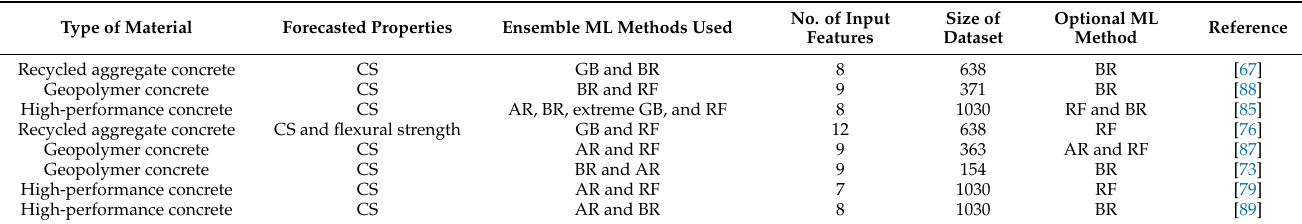
Table 4. Ensemble machine learning models employed previously.